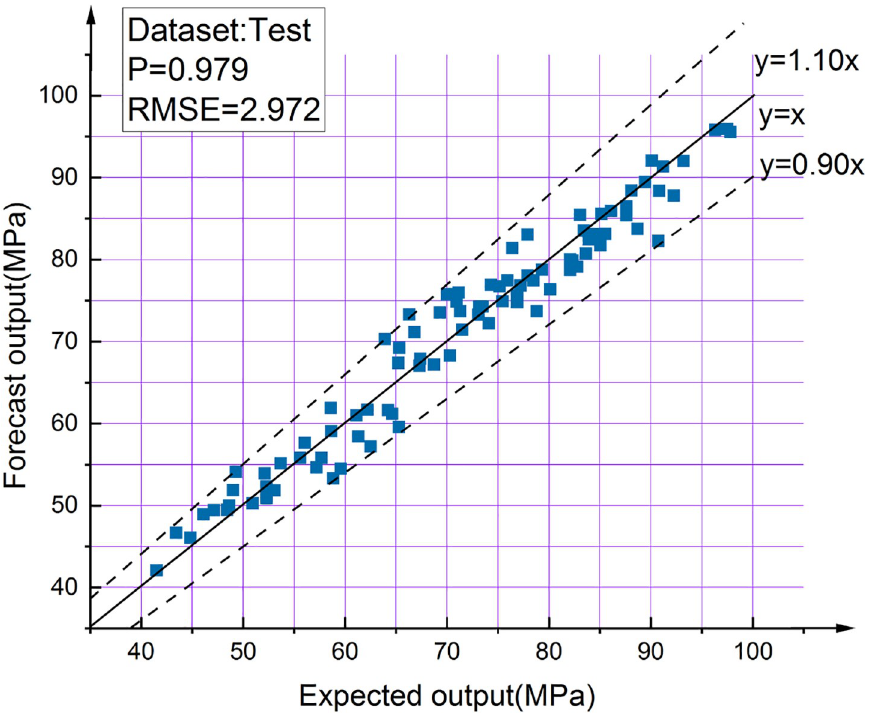
Fig 23. GA-BPNN output